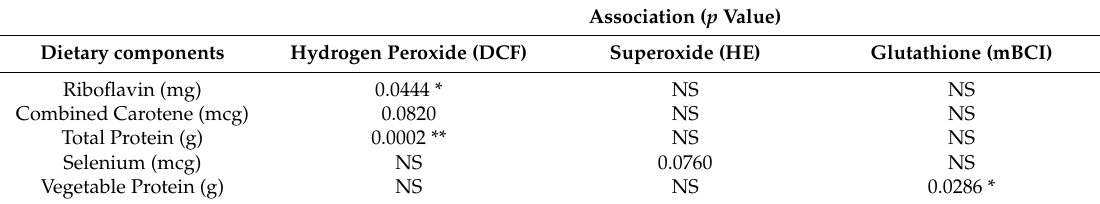
Table 5. Multi-level regression model adjusted for age and visit examining the relationships between oxidative stress measures a and dietary components.